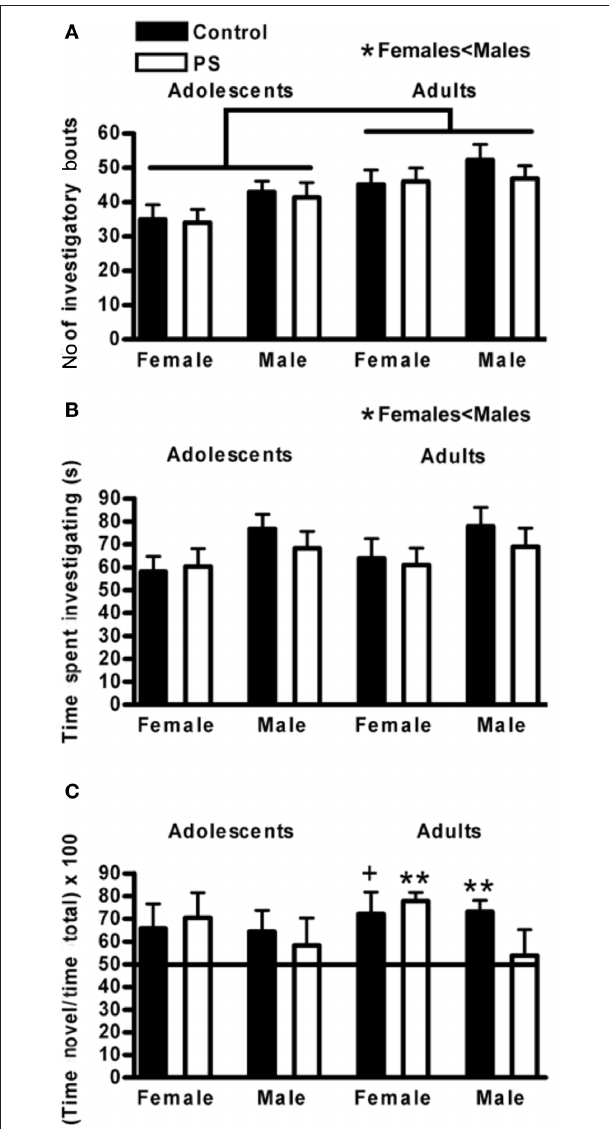
Figure 2 | Novel object recognition. (A) During the introduction phase, adolescents initiated fewer investigatory bouts with the objects compared to adults ( p < 0.0001) and females engaged in fewer investigatory bouts than males (* p < 0.04). (B) Females also spent less time overall investigating the objects during the introduction than males (* p < 0.02). (C) Object recognition memory matured over the periadolescent time frame; adolescents were not competent on this task whereas adult control males (** p < 0.01) and control females ( + p < 0.066) performed above chance. Prenatally stressed (PS) males failed to gain competence on this task ( p > 0.7), whereas PS females were unaffected (** p < 0.01). Lines above graphs indicate significant group differences. Values are group mean ± SEMs.